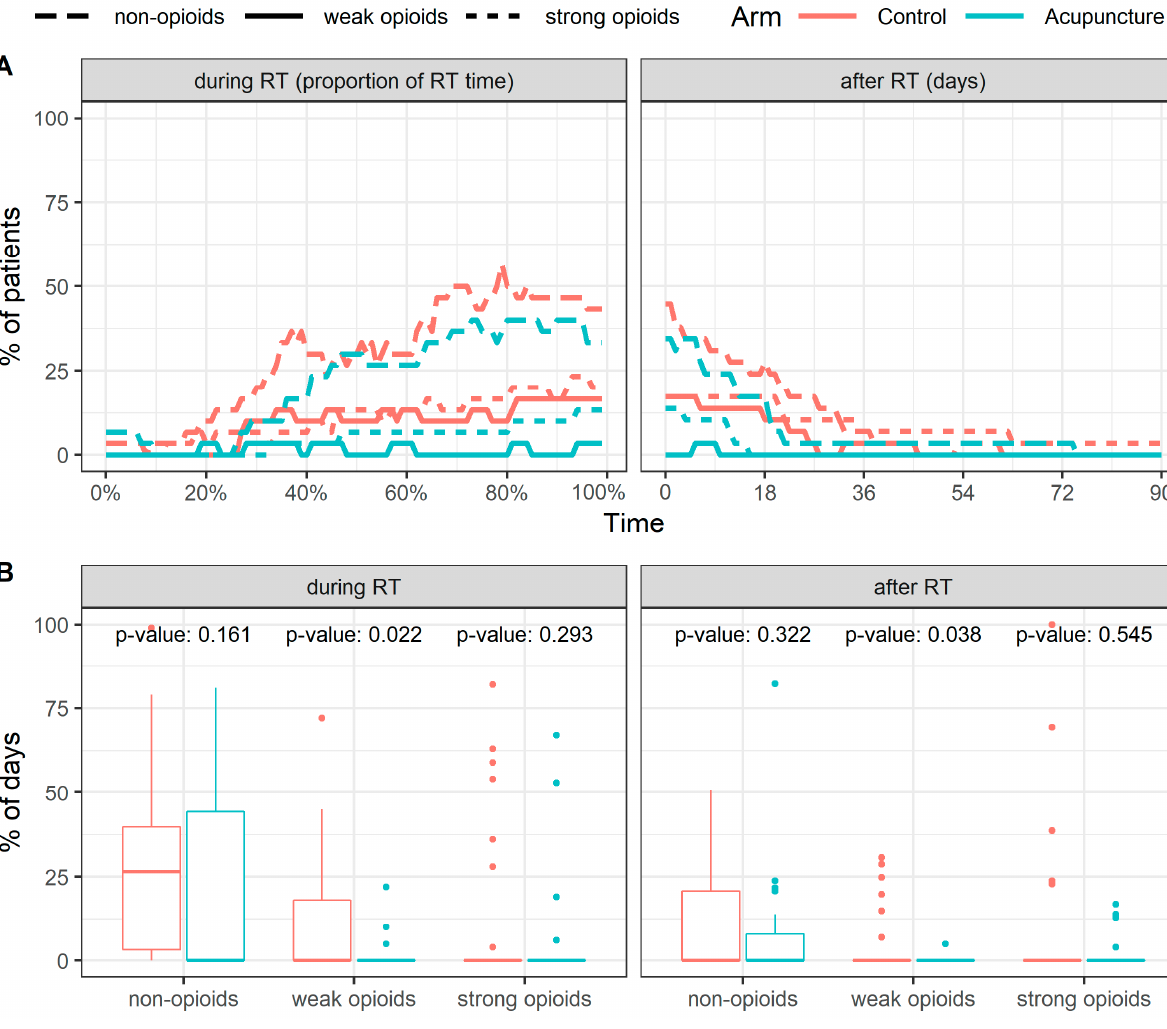
Figure 5. ( A ) Time course and ( B ) the key moments during the treatment of the proportion of patients requiring analgesic therapy divided according to the individual groups of analgesics.